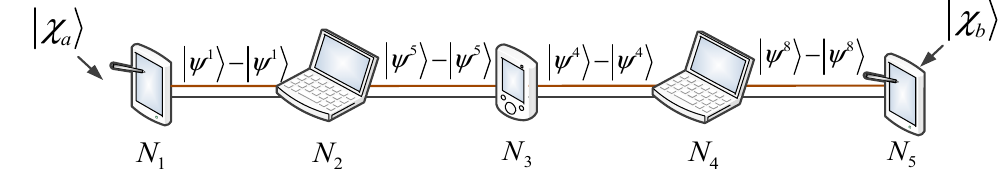
Figure 6. An example of multi-hop bidirectional quantum communication.